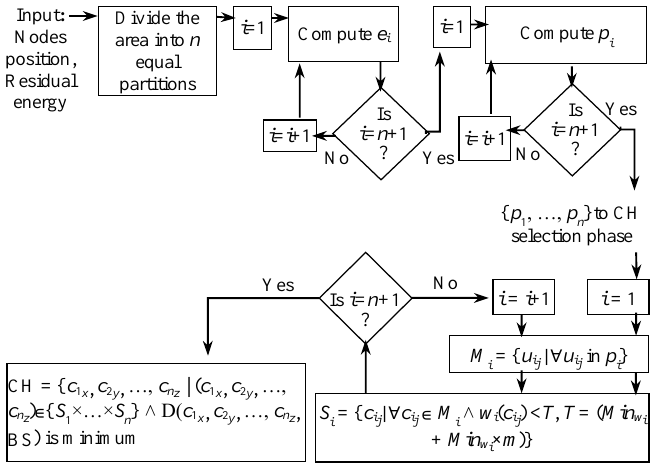
Figure 4. Proposed cognitive partitioning and single round CH selection